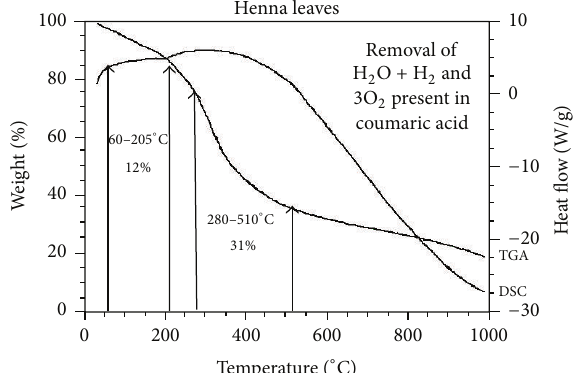
Figure 3: FTIR spectra of FeNPs synthesized using Henna leaves extract.